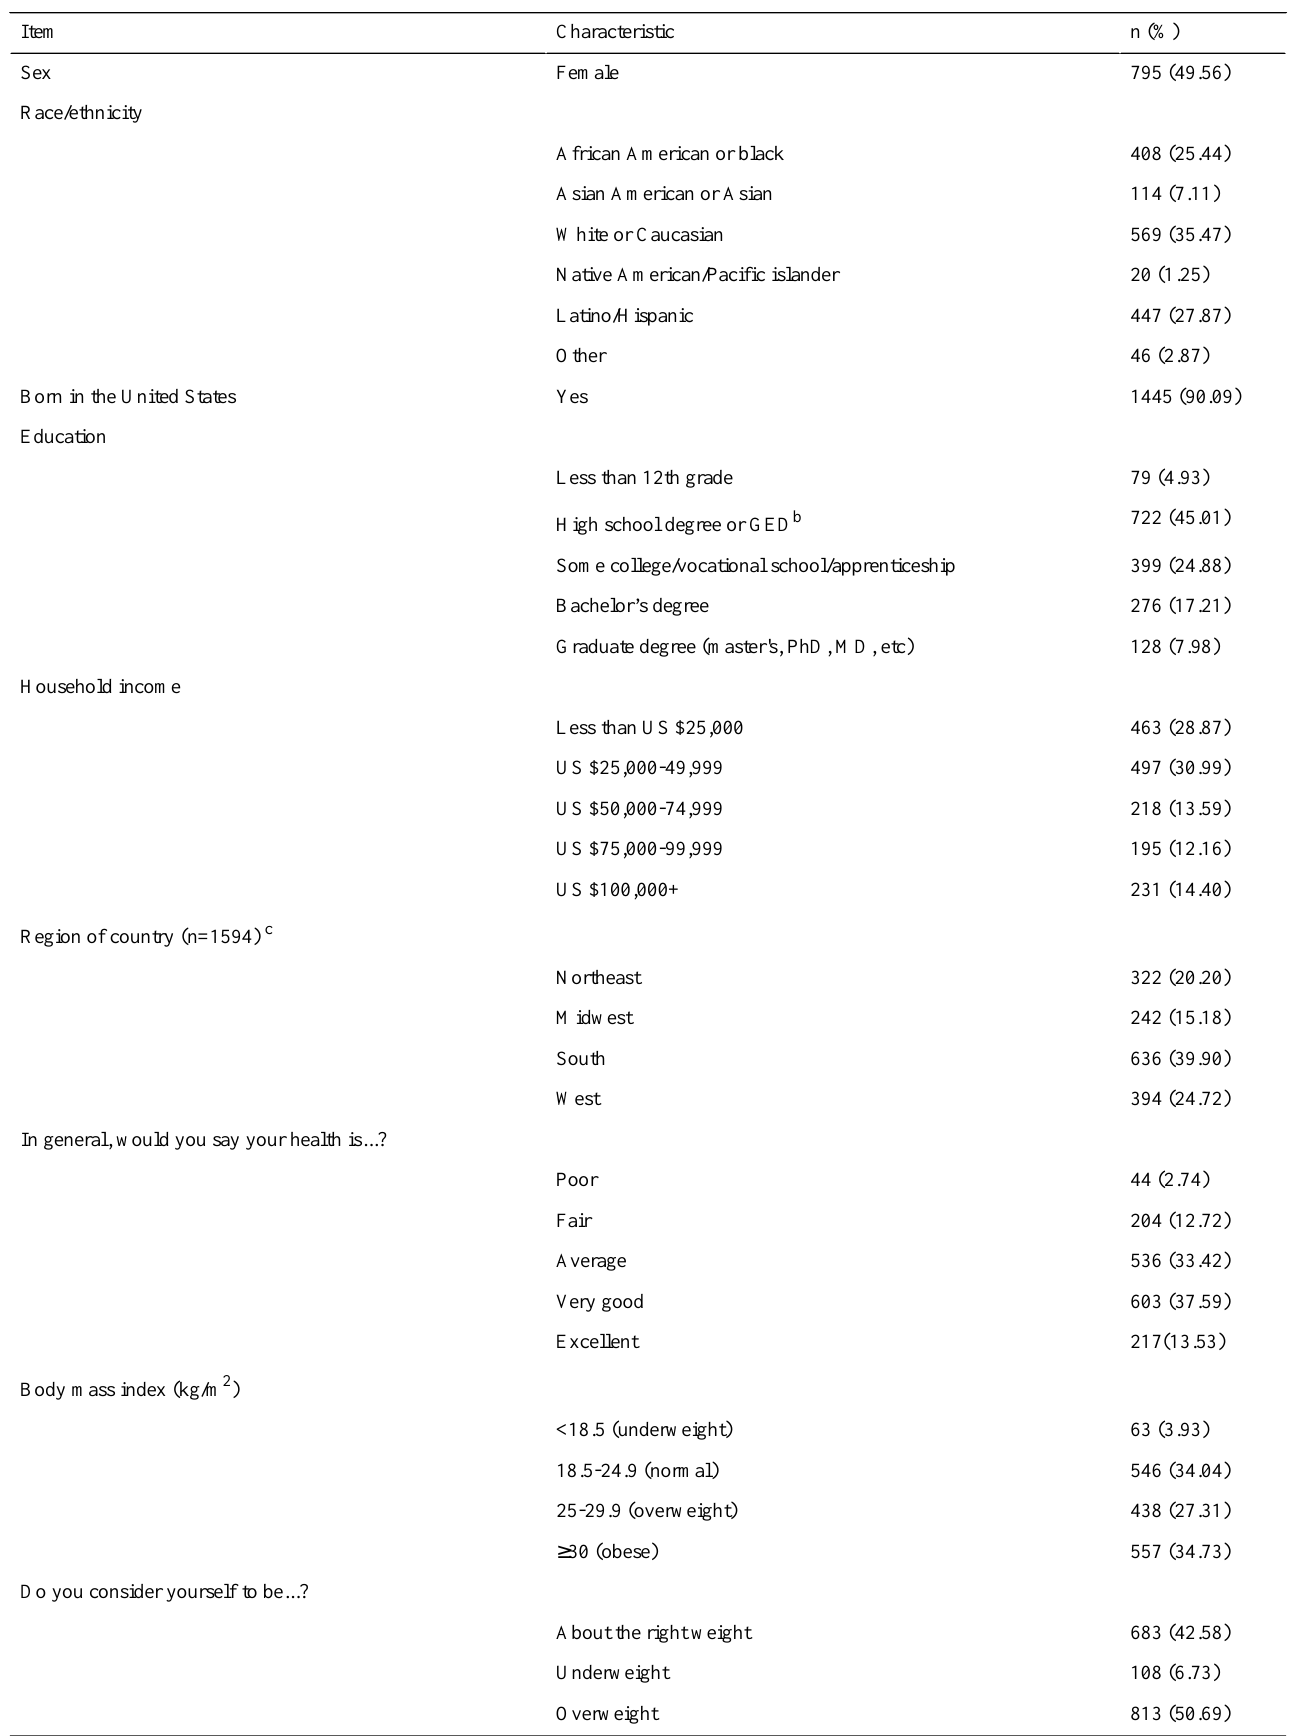
Table 1. Sociodemographic and health characteristics of the sample (abridged a )